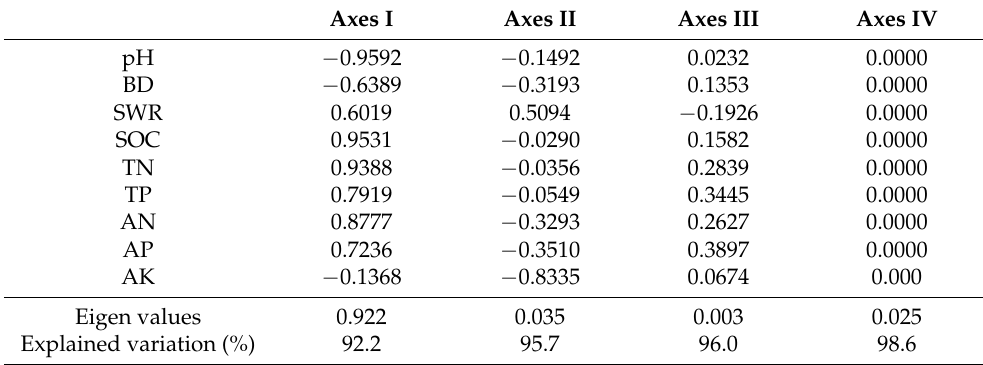
Table 3. Correlation of soil physicochemical factor with the axes by redundancy analysis (RDA) in NVR land.